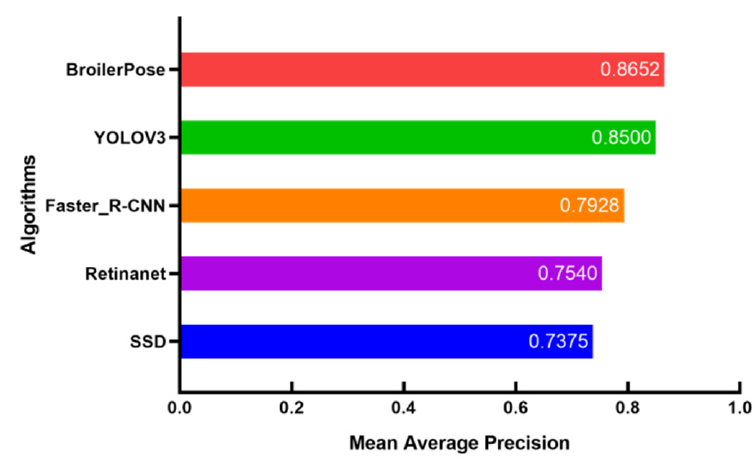
Figure 6. The performance of different algorithms in mAP. Table 2. Comparison of training effects of different algorithms.